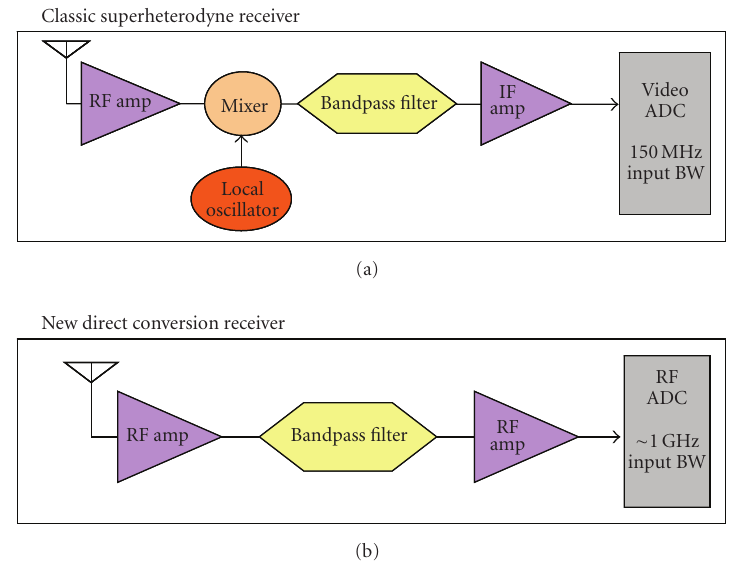
Figure 1: Comparing direct conversion to super-heterodyne architectures. The direct conversion approach does not require an external local oscillator. Rather, the FPGA synthesizes a local oscillator and computationally tunes the desired RF